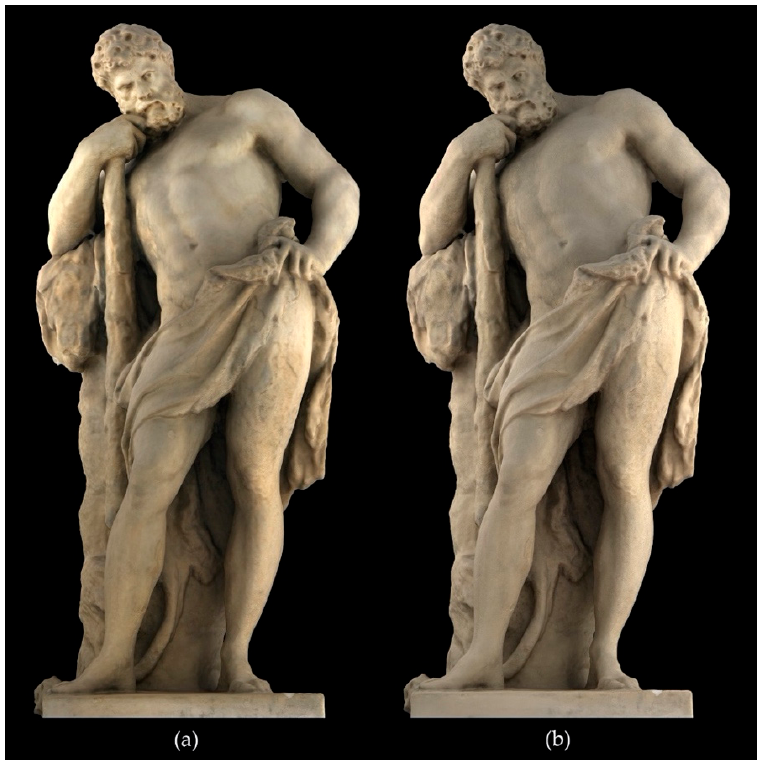
Figure 22. Hercules statue 3D model: ( a ) without CC, ( b ) with CC.